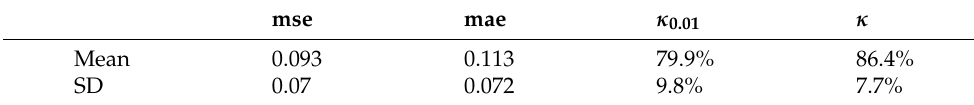
Table 4. Summary of